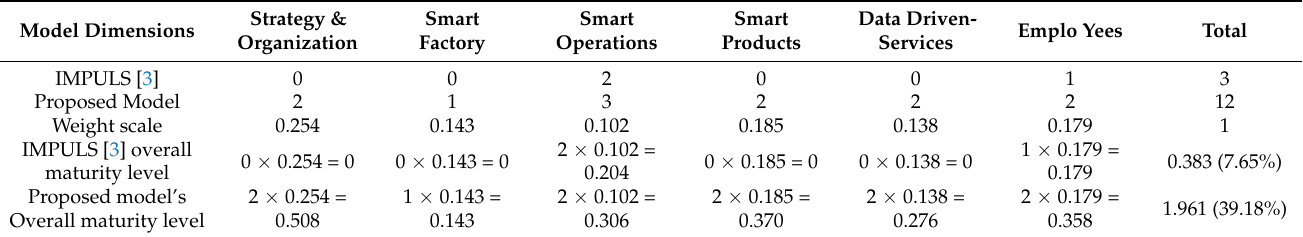
Table 4. I4.0 maturity models